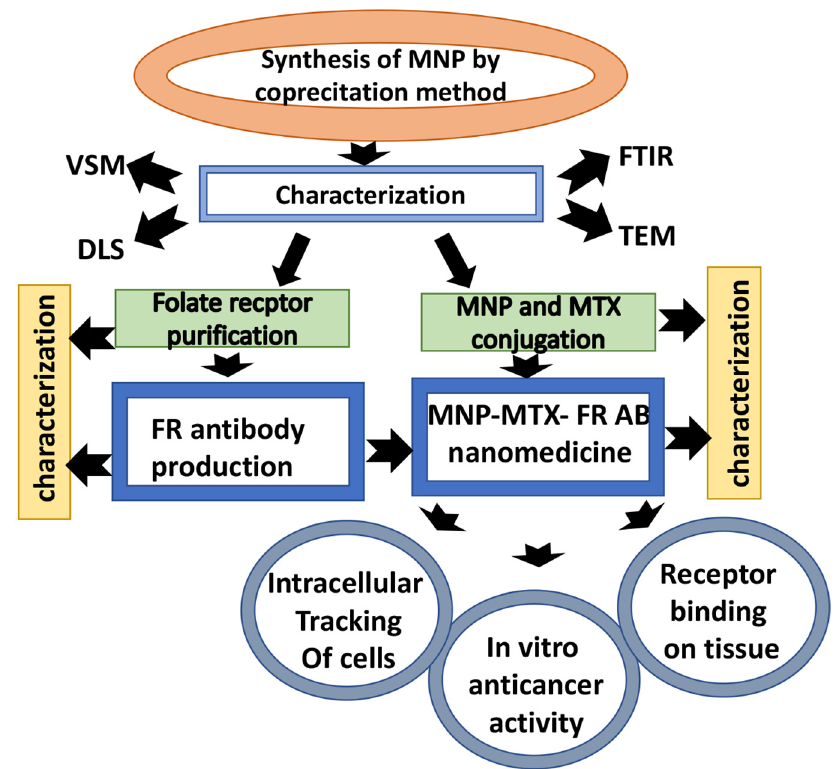
Figure 1. Flow chart of research